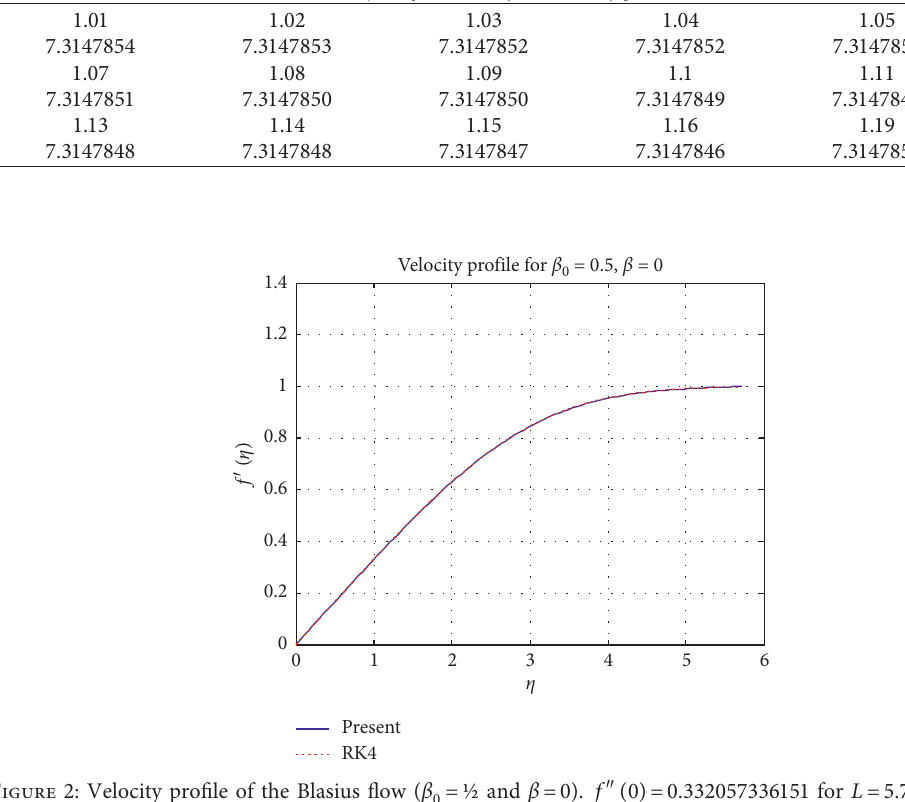
Table 2: Effect of η on f ″ ( 0 ) for β � 40 and β